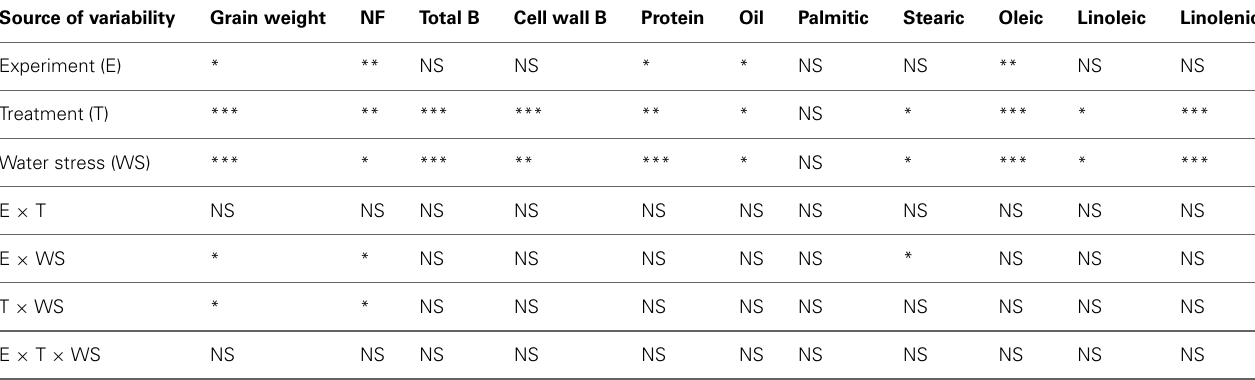
Table 1 | Analysis of variance of the effects of foliar boron on leaves and seed components. Source of